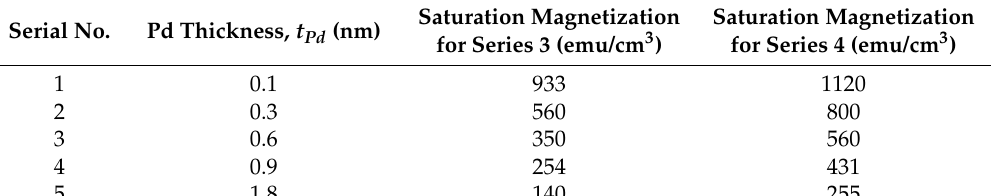
Figure 7. In-plane (black square) and out-of-plane (red circle) magnetic hysteresis loops of sample ( a ) (Co 0.4 /Pd 0.1 ) ×10 , ( b ) (Co 0.4 /Pd 0.3 ) ×10 , ( c ) (Co 0.4 /Pd 0.6 ) ×10 , ( d ) (Co 0.4 /Pd 0.9 ) ×10 , ( e ) (Co 0.4 /Pd 1.8 ) ×10 of series 4 with (Co 0.4 /Pd Pd) ×10 . t Pd